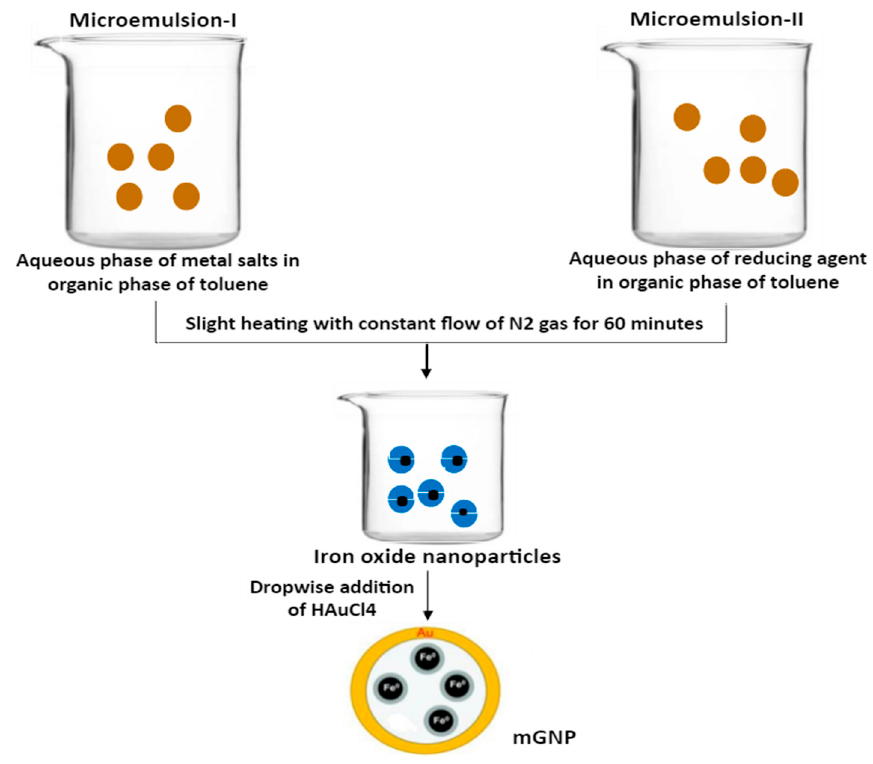
Figure 3. Schemes of synthesizing magnetic gold nanoparticles by microemulsion technique.